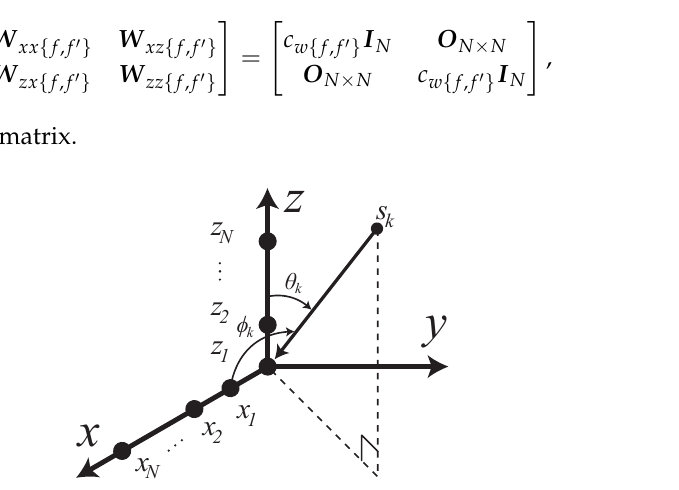
Figure 1. L-shaped microphone array configuration for 2D DOA